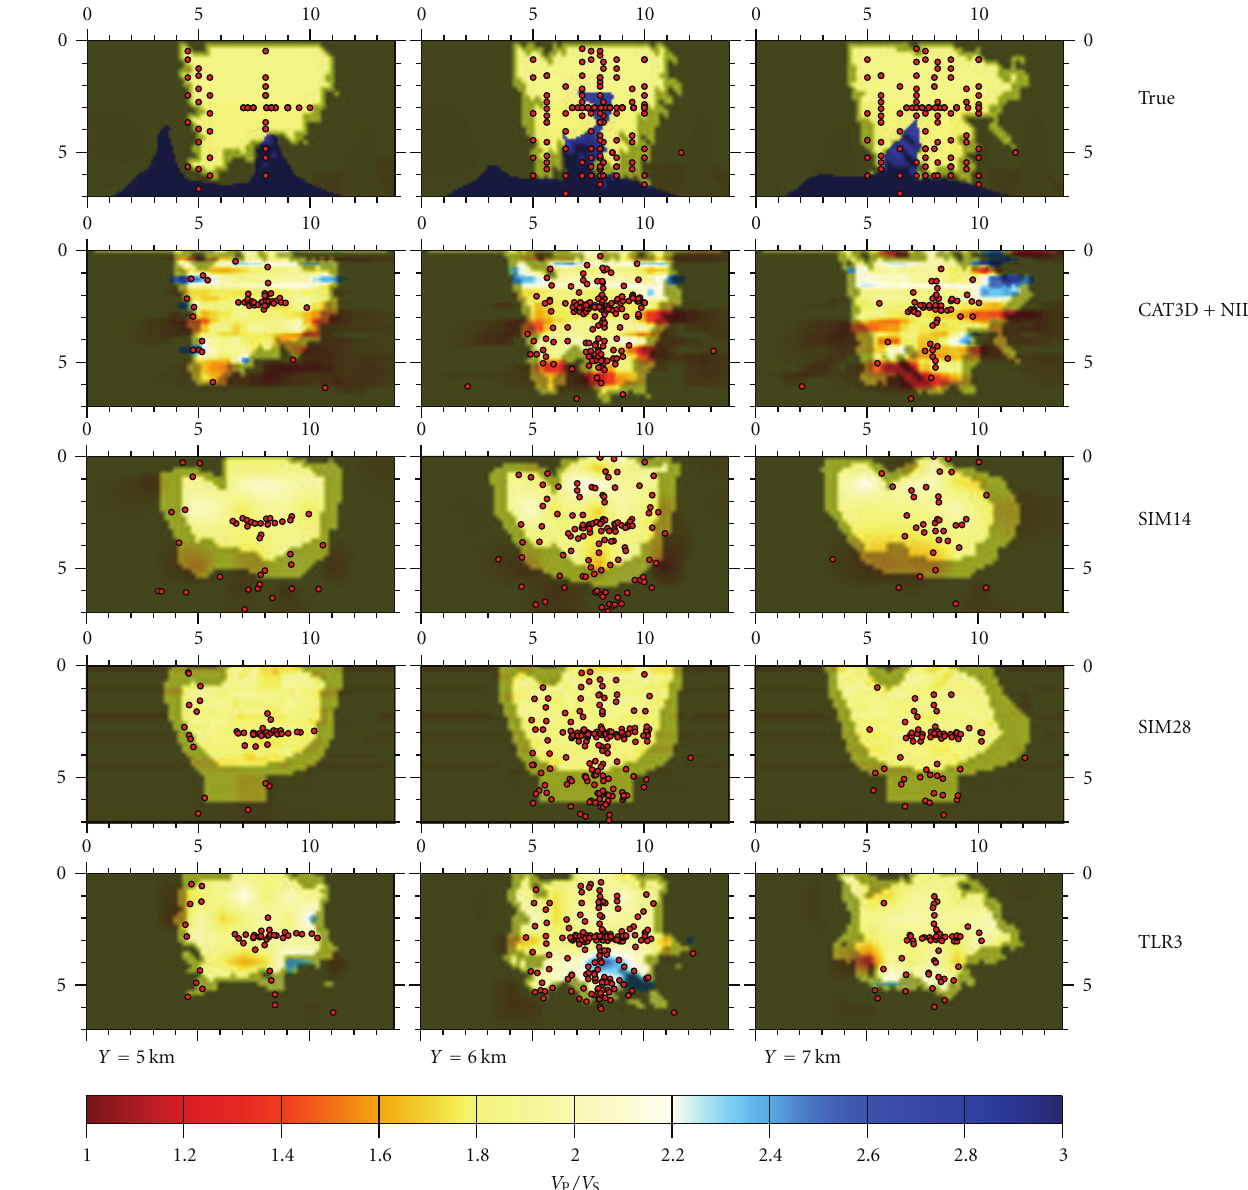
Figure 20: Same as Figure 16, in this case for V P /V S